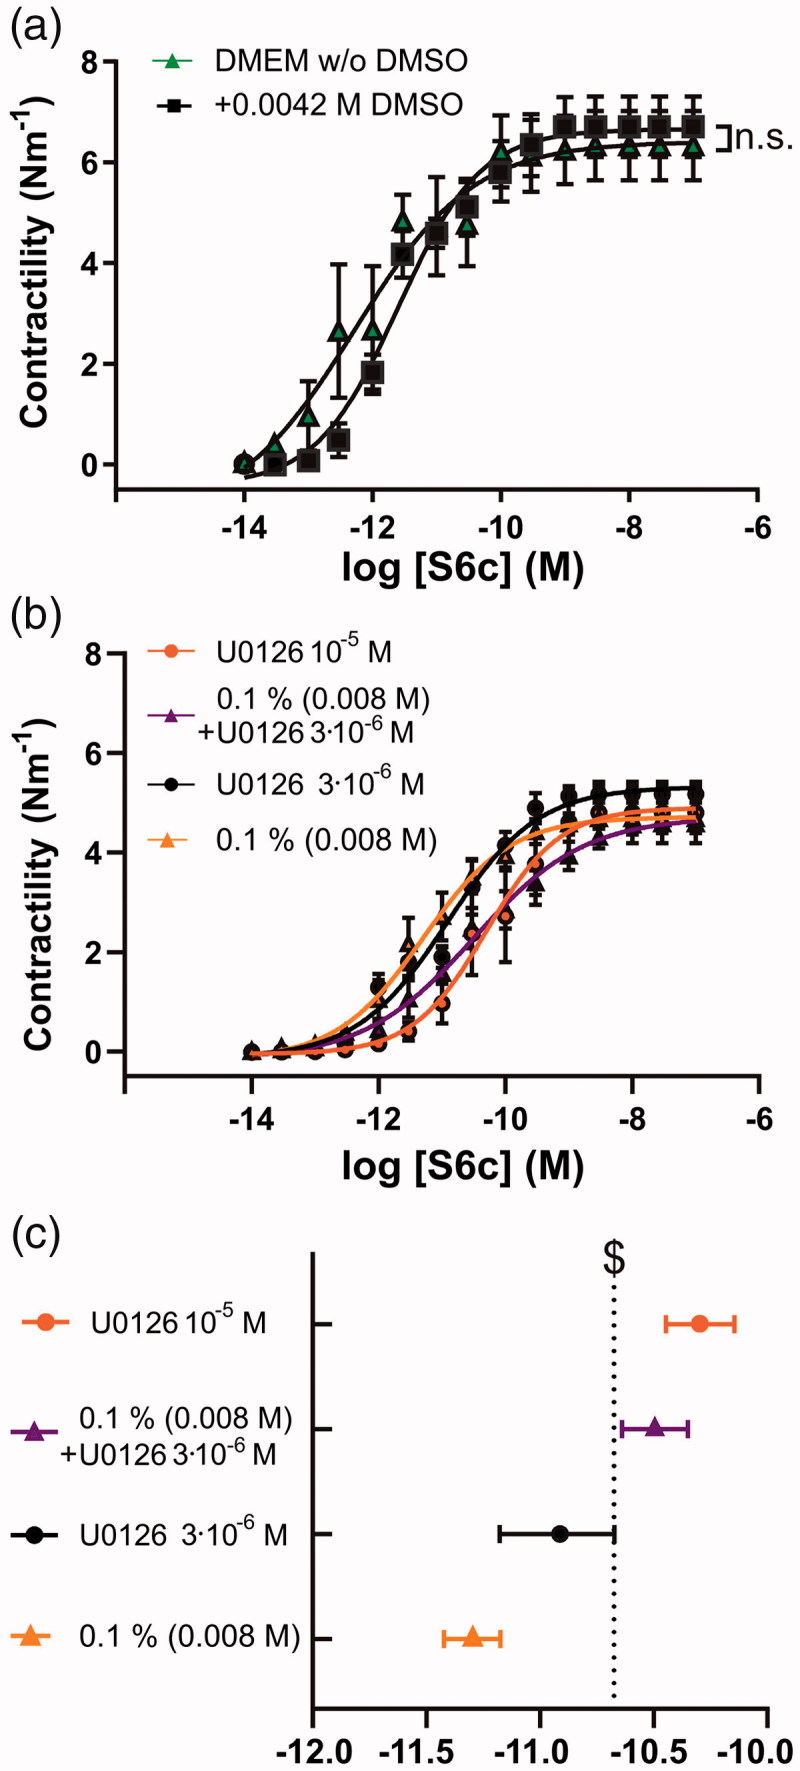
Additive effect of cremophor and U0126 on S6c contractility after 48 h organ culture. (a) Basilar arteries were incubated without DMSO and with 0.0042 M DMSO which is the corresponding concentration for the 3 × 10−6 M U0126. (b) Concentration-response curves with S6c of basilar arteries incubated with cremophor and different concentrations of U0126 in DMSO or cremophor. (c) Comparison of the log EC50 values of the different concentrations of U0126 in DMSO or cremophor based on the concentration-response curves with S6c. When 0.1% is stated it refers to 0.1% cremophor. $ = non-overlapping 95% confidence intervals. Data are expressed as mean ± SEM, n = 6–7.